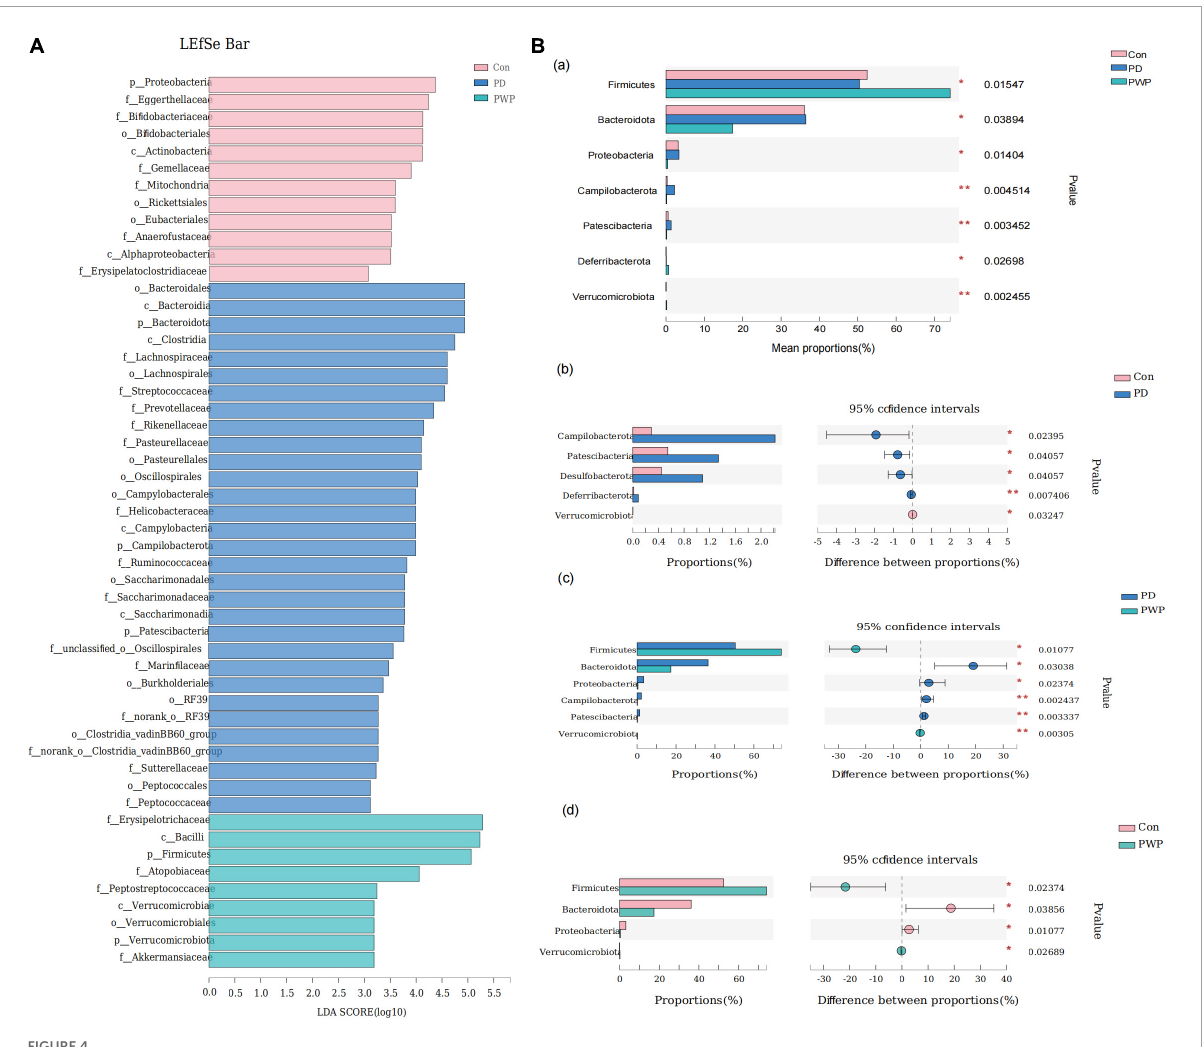
FIGURE4 The result of 16S microbiome analysis. (A) LEfSe bar of control, PD, and PWP groups. (B) Results of Kruskal-Wallis H test, showing difference between groups.